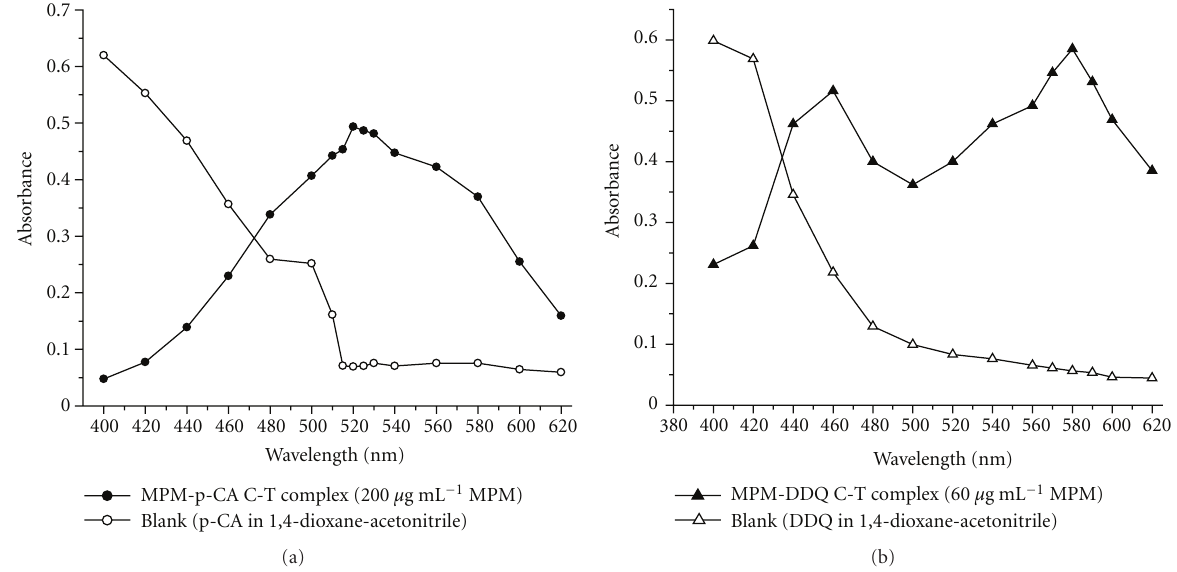
Figure 1: Absorption spectra of (a) MPM-p-CA C-T complex and its blank and (b) MPM-DDQ C-T complex and its blank.